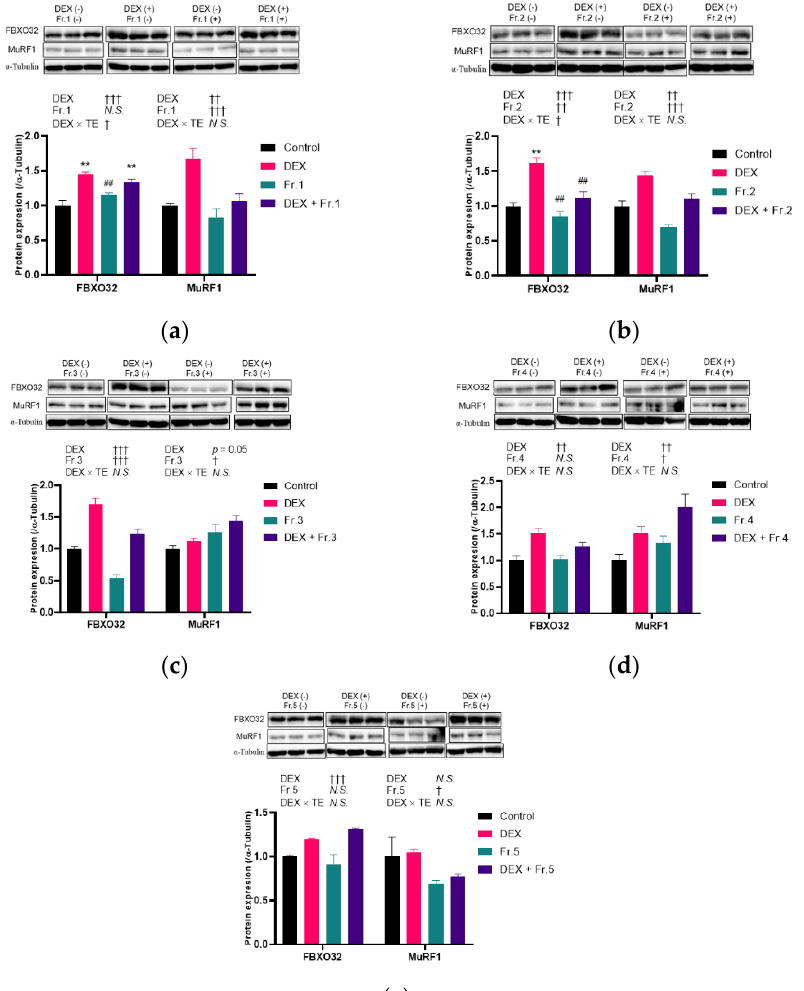
Figure 5. Effects of five turmeric extract (TE) fractions on the gene expression of muscle-specific ubiquitin ligase in dexamethasone (DEX) – treated C2C12 myotubes. ( a ) and ( b ) Gene expression of Fbxo32 and Murf1, respectively. The positive control group was treated with 10 nM of IGF-1 for 12 h. The results are shown as the mean ± standard error ( n = 4), and statistical analysis was performed by Tukey-Kramer test. ** p < 0.01 vs. Control, N.S.: not significant.